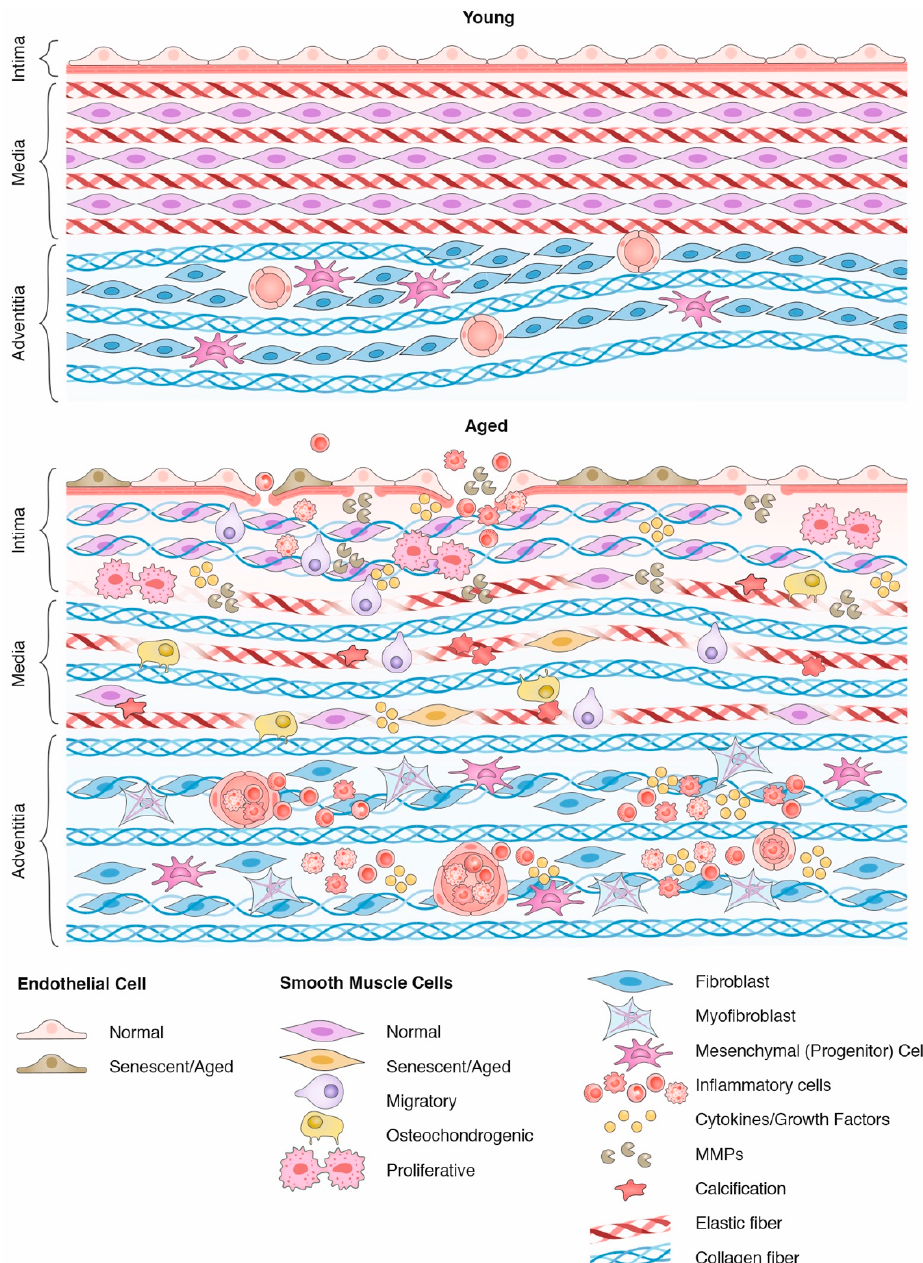
Figure 1. Age-mediated changes in the arterial wall. The upper panel demonstrates the typical features of a young artery, formed by endothelial cells supported by a basement membrane (intima layer), followed by concentric SMC layers in association with elastic fibers, forming lamellar units in the medial layer. Fibroblasts and mesenchymal (progenitor) cells form the adventitial layer along with wavy collagen fibers and vasa vasorum. With aging (bottom panel), endothelial cells become senescent, facilitating the infiltration of inflammatory cells. In the medial layer, elastic fibers become calcified and fragmented, while collagen secretion increases, culminating in vascular stiffening. These changes expose SMC to greater mechanical stress, leading to a broad spectrum of phenotypes that only accentuate arterial aging through the senescence ‐ associated secretory phenotype (SASP). In the adventitia, inflammatory cells use the vasa vasorum to infiltrate the arterial wall, while collagens distend and fibroblasts transdifferentiate into myofibroblasts.